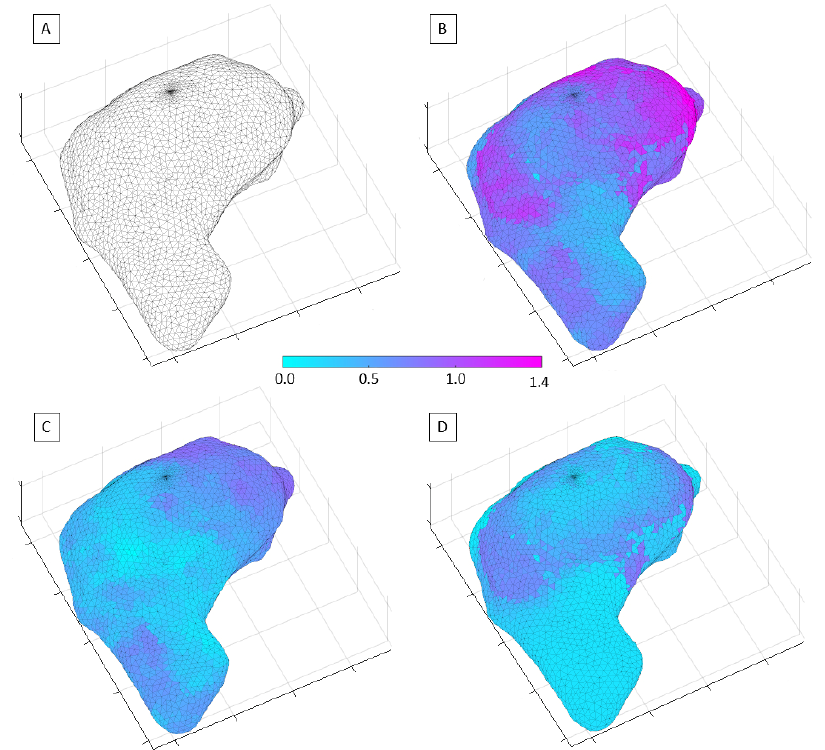
Figure 2. Representation of the MR image distortion fields relevant to liver RT and imaging performed on the Unity-MR system: ( A ) 3D mesh of the liver volume used to plot the distortion field distri- bution; ( B ) total distortion values; ( C ) system-related spatial distortions; ( D ) susceptibility-induced geometric